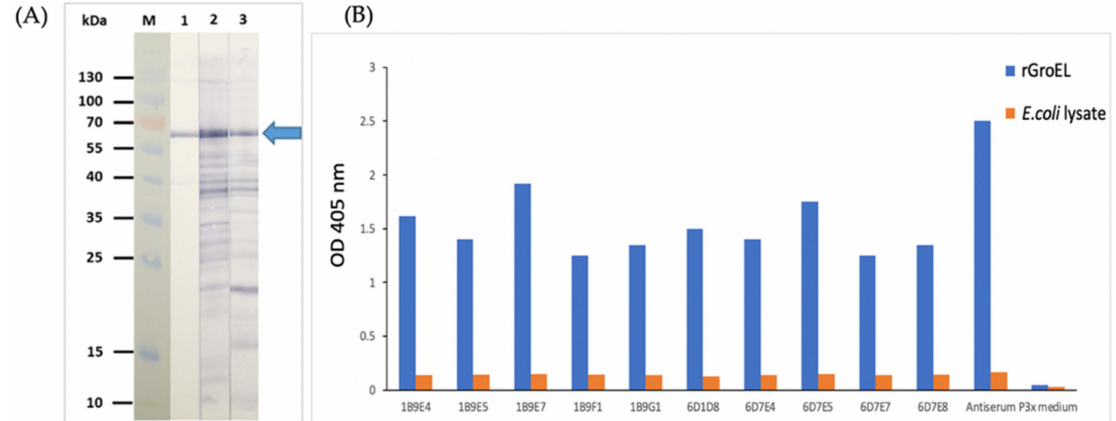
Figure 2. Mouse and rabbit sera immune to rGroEL and mouse hybridomas secreting monoclonal antibodies against rGroEL. ( A ) Western blot patterns of the mouse and rabbit polyclonal antibodies that bound to the SDS-PAGE-separated rGroEL of O. tsutsugamushi. Lane M, protein molecular mass marker; lane 1, positive control, i.e., the SDS-PAGE-separated rGroEL probed with anti-His monoclonal antibody; lane 2, SDS-PAGE-separated rGroEL probed with serum of immunized mouse number 1; lane 3, SDS-PAGE-separated rGroEL probed with rabbit immune serum. Numbers on the left are protein masses in kDa. The rGroEL-antibody reactive bands are indicated by arrow. ( B ) OD 405 nm of indirect ELISA for testing binding of monoclonal antibodies in culture supernatants of 10 hybridomas to purified rGroEL in comparison with the control antigen (lysate of original BL21 (DE3) E. coli host). Mouse serum immune to rGroEL (Antiserum) and culture supernatant of the P3x-63-Ag8.653 mouse myeloma cells P3x medium) were included as positive and negative binding